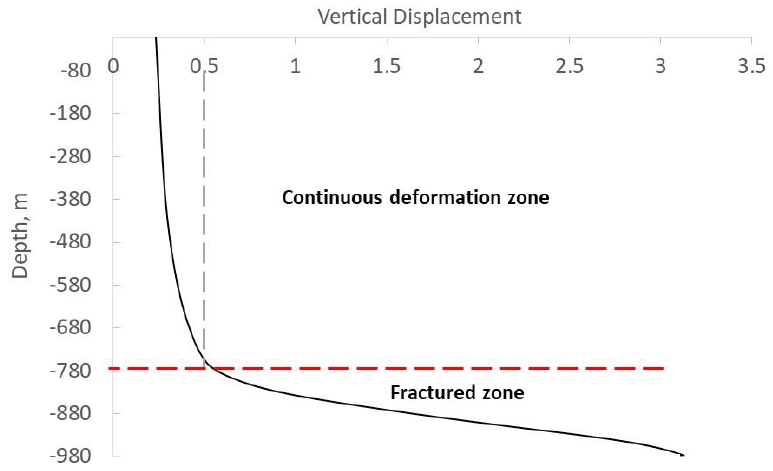
Figure 5. Vertical displacement along the center of the goaf.